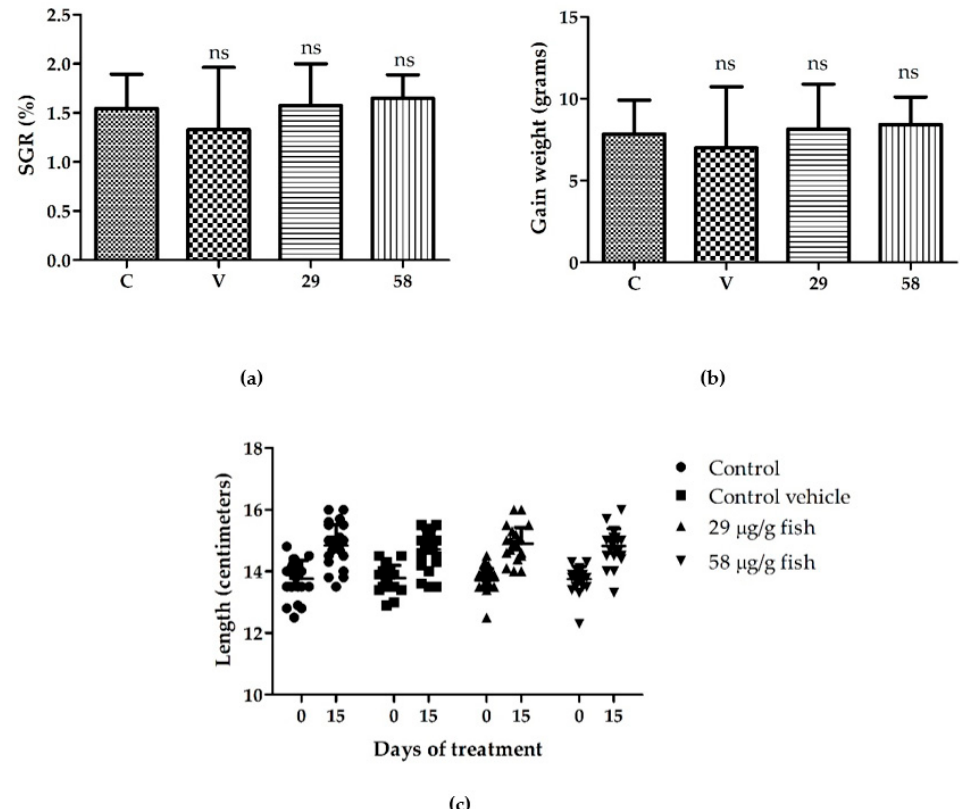
Figure 2. Growth performance of rainbow trout fed with and without [Cu(NN 1 ) 2 ](ClO 4 ) complex supplemented diet. C = control, V = vehicle control, 29 = 29 µg/g of fish, and 58 = 58 µg/g of fish: ( a ) % SGR; ( b ) gain weight, ( c ) fish length at the beginning and end of the experiment. Statistical analysis nonparametric Mann-Whitney t- test with a p < 0.05, ns indicates no significant difference.